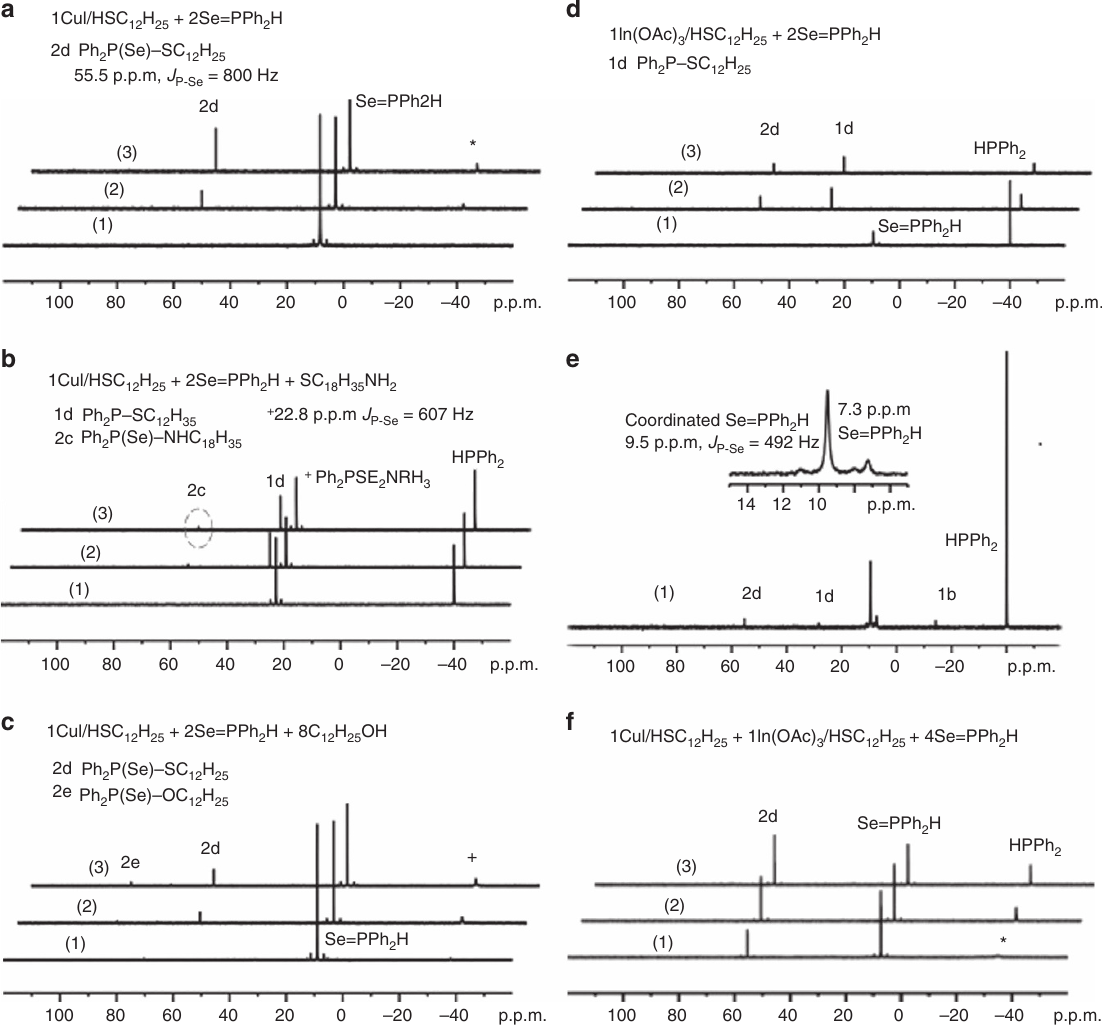
Figure 4 | 31 P NMR spectra of Cu/In-containing reaction mixtures. ( a ) CuI/C 12 H 25 SH þ 2Se ¼ PPh 2 H, with RT (1), 80 (cid:2) C per 10min (2) and 100 (cid:2) C per 10min (3). ( b ) CuI/C 12 H 25 SH þ 2Se ¼ PPh 2 H þ 8C 18 H 35 NH 2 , with RT per 10min (1), 100 (cid:2) C per 15min (2) and 100 (cid:2) C per 75min (3). ( c ) CuI/ C 12 H 25 SH þ 2Se ¼ PPh 2 H þ 8C 12 H 25 OH, with RT (1), 80 (cid:2) C per 10min (2), 100 (cid:2) C per 10min (3). ( d , e ) In(OAc) 3 /C 12 H 25 SH þ 2Se ¼ PPh 2 H, with RT per 15min (1), 80 (cid:2) C per 10min (2), 100 (cid:2) C per 10min (3) for d and RT per 15min (1) for e (repeated with 512 scans). ( f ) CuI/C 12 H 25 SH þ In(OAc) 3 / C 12 H 25 SH þ 4Se ¼ PPh 2 H, with RT per 15min (1), 80 (cid:2) C per 5min (2) and 100 (cid:2) C per 5min (3). The peak denoted with an asterisk (*) was assigned to HPPh 2 complexed to Cu (ref.